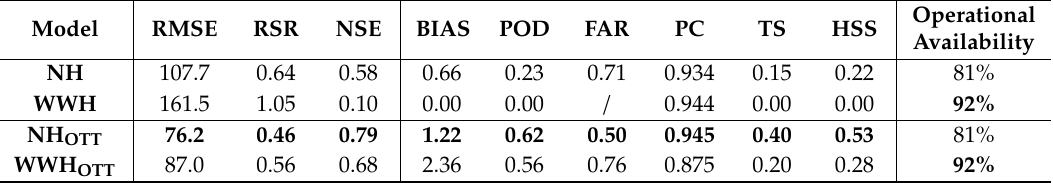
Table 7. Continuous and categorical indices and operational availability for original and optimized forecasts (mean values of Garbey Kourou and Bossey Bangou). Best performance is shown in